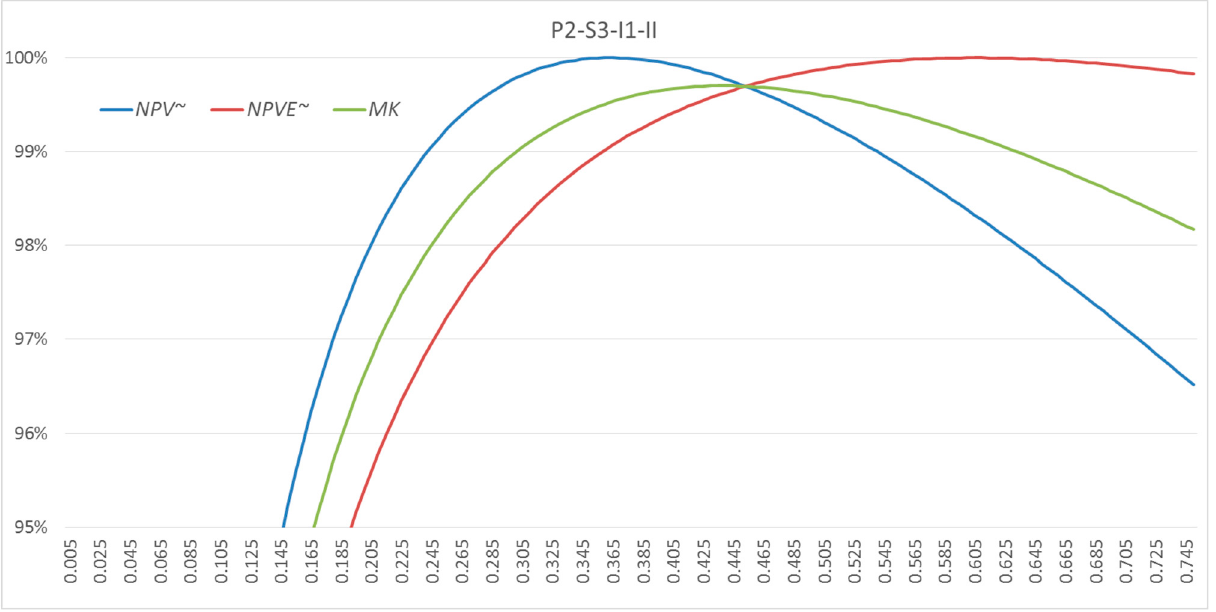
Table 10. Optimum insulation thicknesses d MKopt (m).